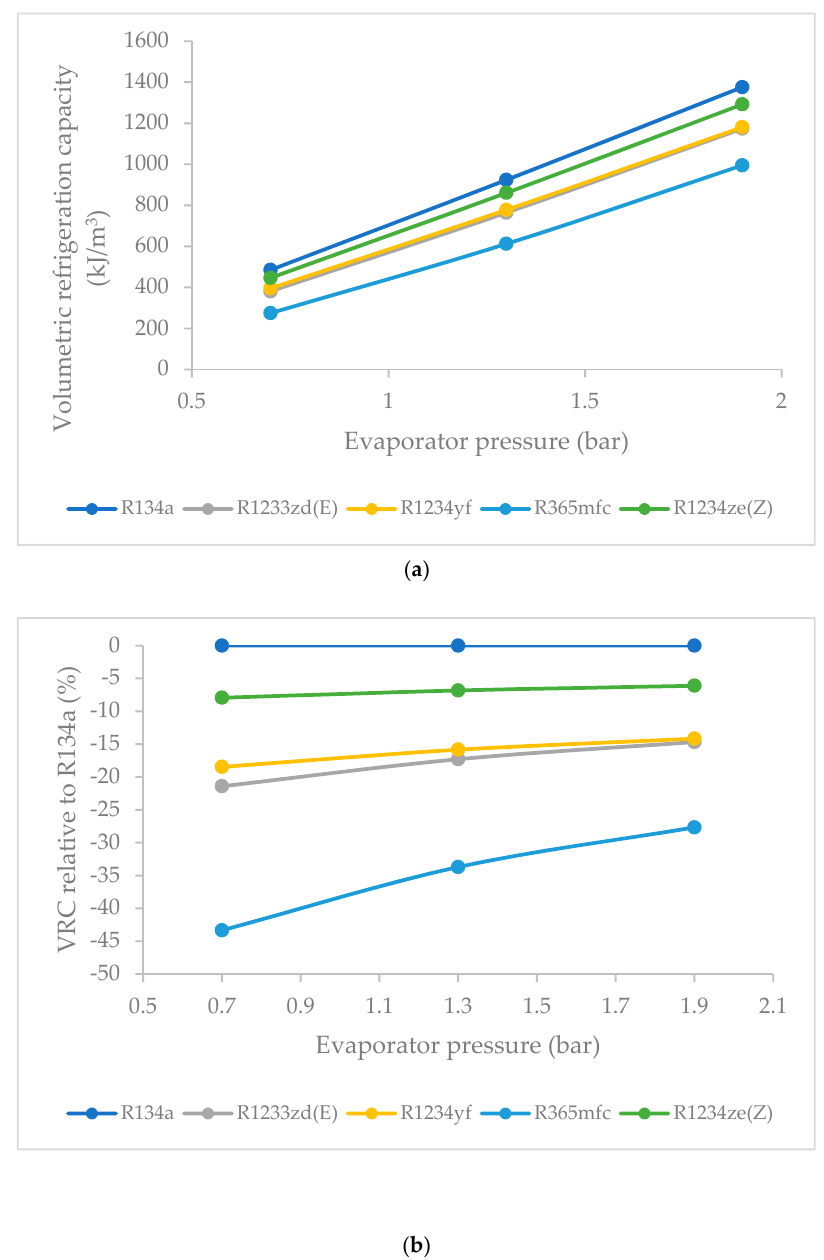
Figure 13. ( a ) VRC as a function of evaporator pressure (condenser pressure = 9 bar). ( b ) VRC relative to R134a (%) (condenser pressure = 9 bar).